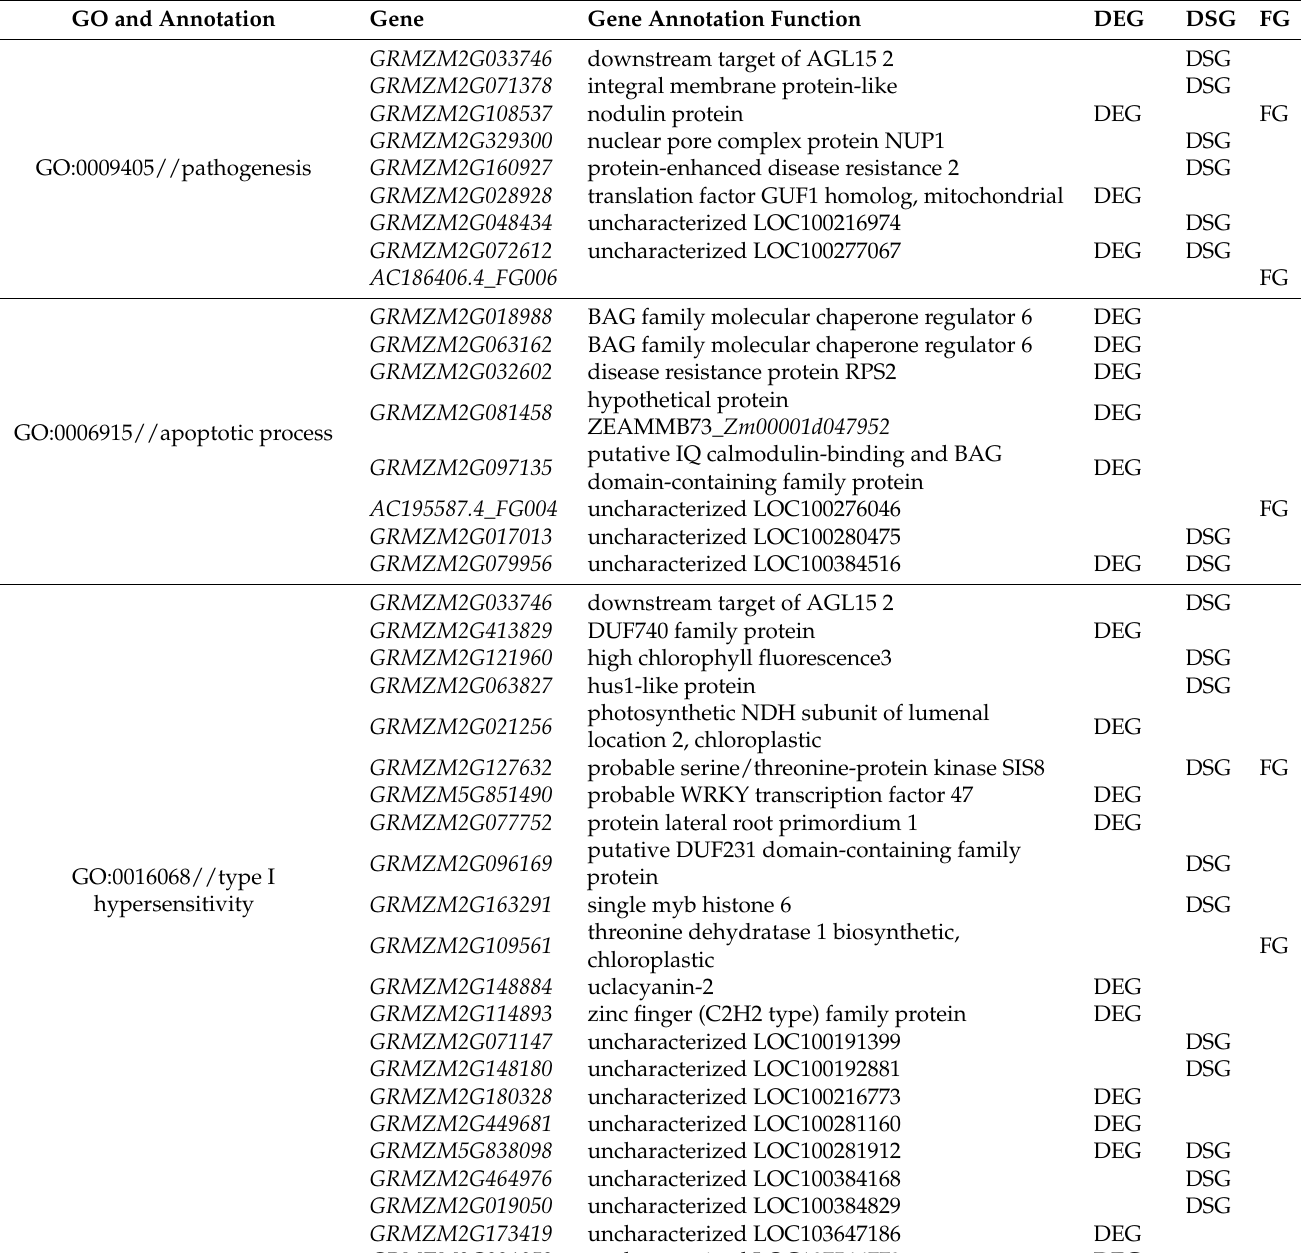
Table 1. DEG, DSG, and FG analysis of important